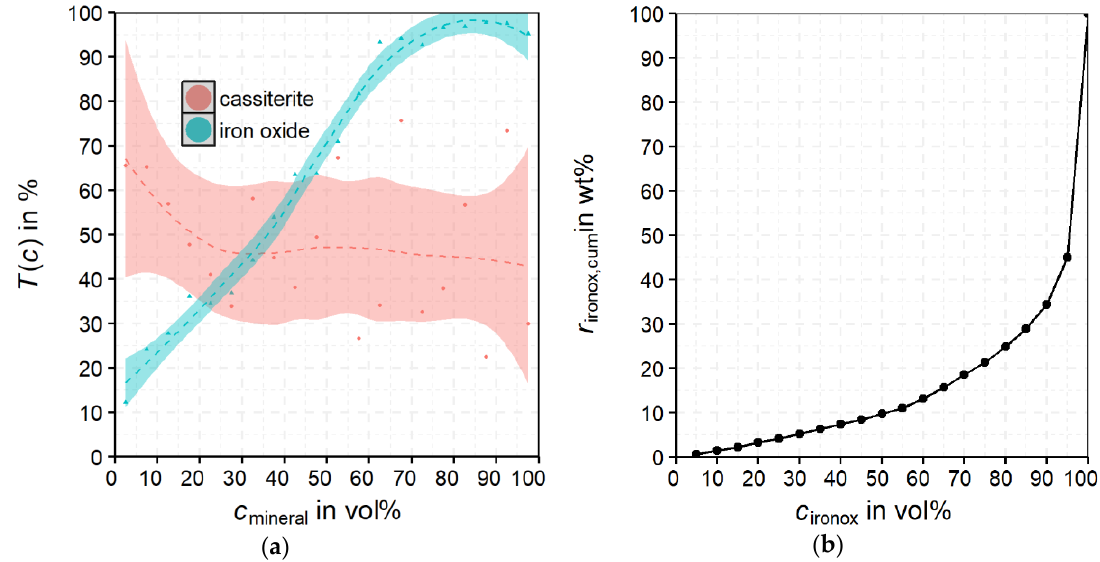
Figure 5. ( a ) T ( c ) vs. mineral content in the particles for cassiterite (red) and iron oxides (blue); ( b ) cumulative distribution of iron oxides (r ironox,cum ) in the content classes ( c ironox ) of the feed material.